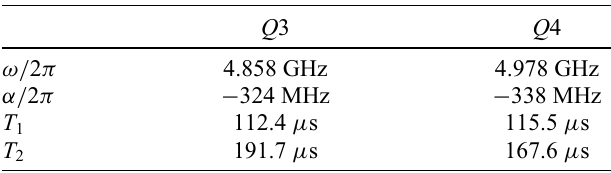
TABLE I. Parameters of